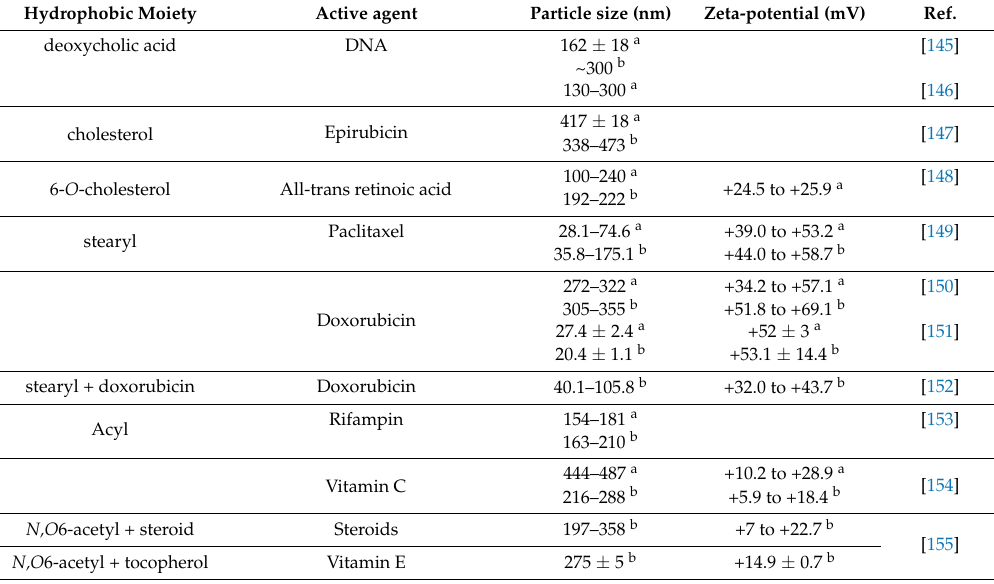
Table 4. Hydrophobically modified chitosan and chitosan